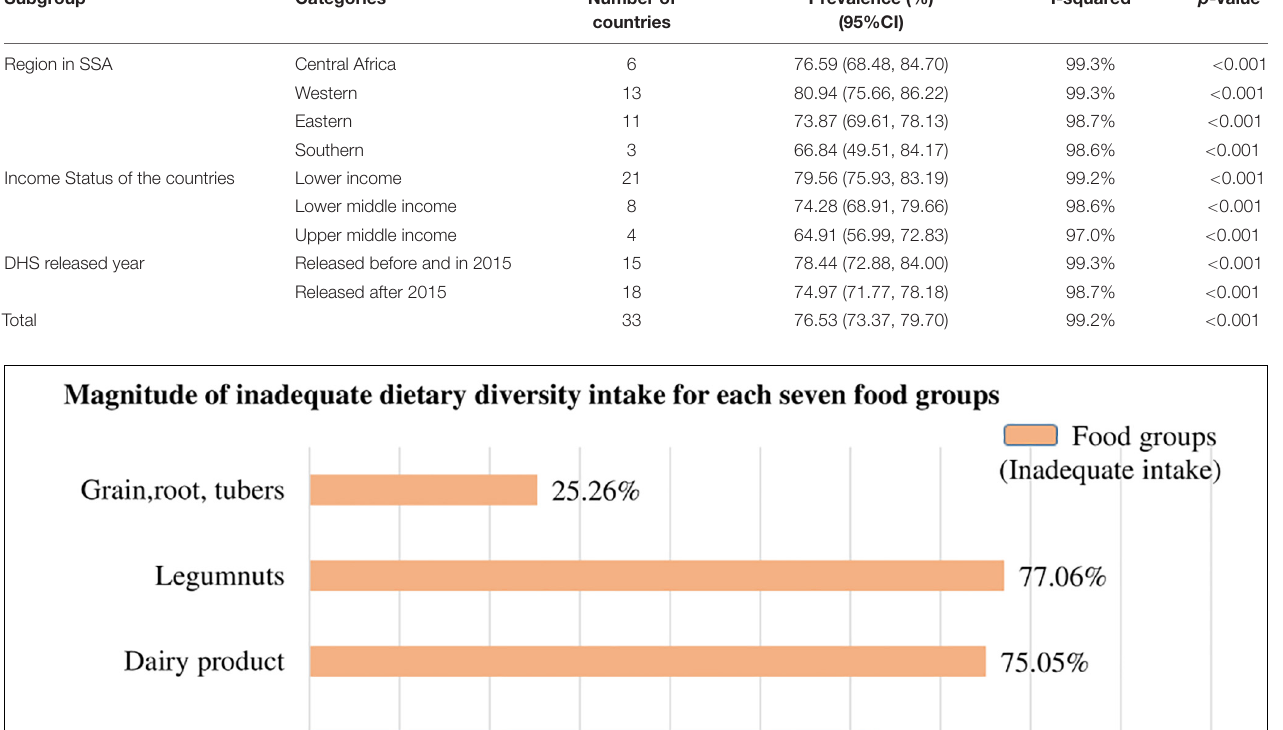
highest log-likelihood and the lowest deviance was the better- fitted model, which was model four (72,558) and selected for interpretation ( Table 6